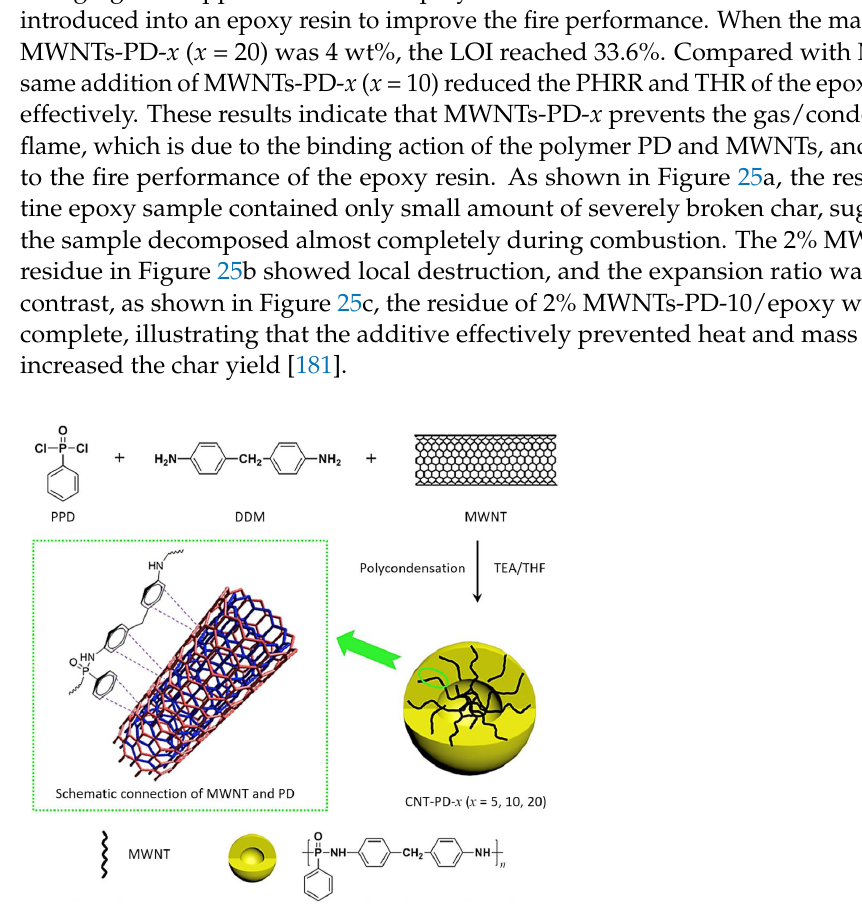
Figure 23. Proposed flame-retardant process for the MWNT-DOPO-OH-based polymer nanocomposites. Reproduced with permission from Ref. [176]. Copyright 2018, Elsevier.